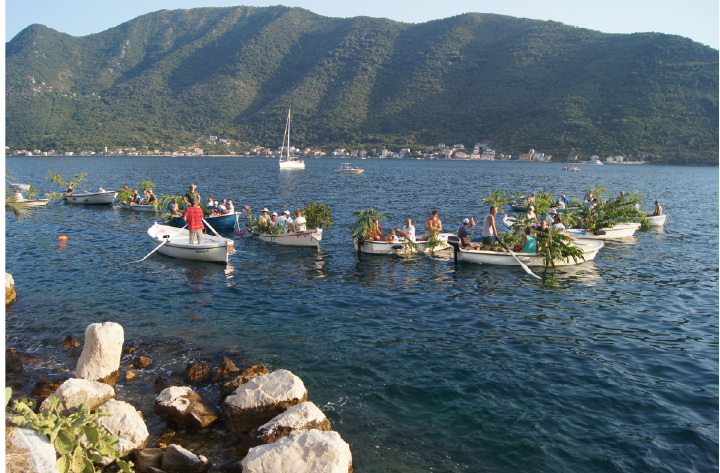
Figure 4. Preparing to start the procession in 2021. Photo by the author.